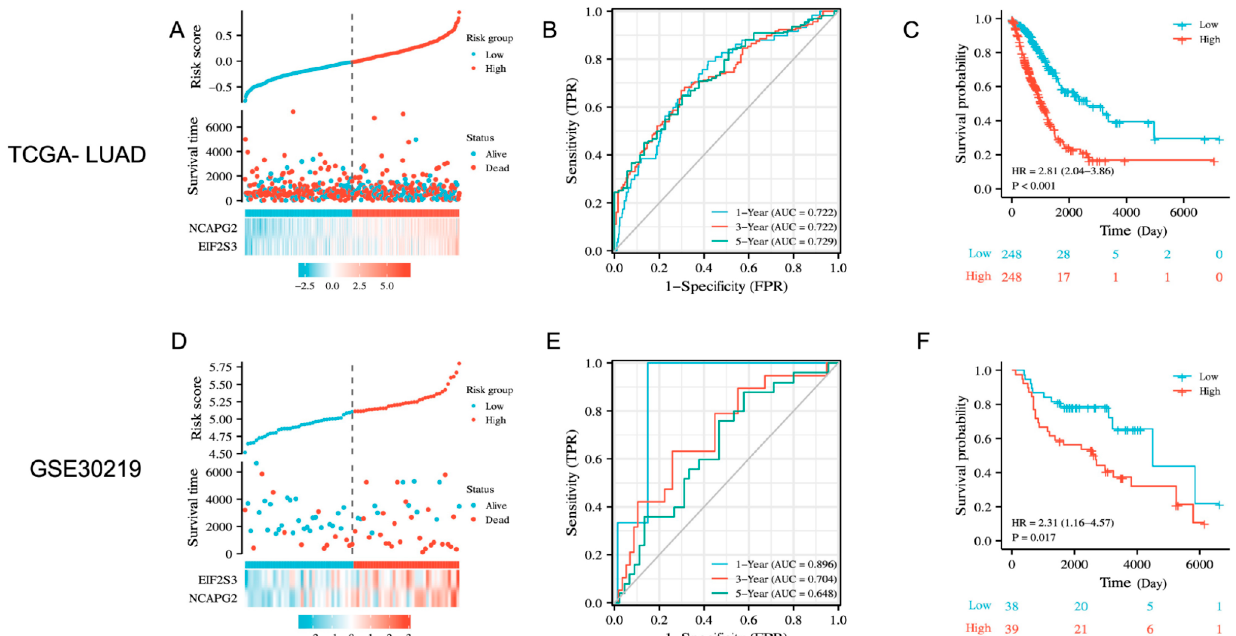
Figure 5. Construction and validation of a prognostic signature for NCAPG2 and EIF2S3 in the TCGA and GEO cohort. ( A ) Distribution of risk scores, survival status, and candidate gene expression for each patient in the high- and low-risk groups of the TCGA cohort. ( B ) AUC of time-dependent ROC curves to assess the predictive efficacy of the prognostic signature for OS in LUAD patients. ( C ) KM survival curve shows OS of LUAD patients in the high- and low-risk groups. ( D – F ) Validation of a prognostic signature for NCAPG2 and EIF2S3 in GSE30219.